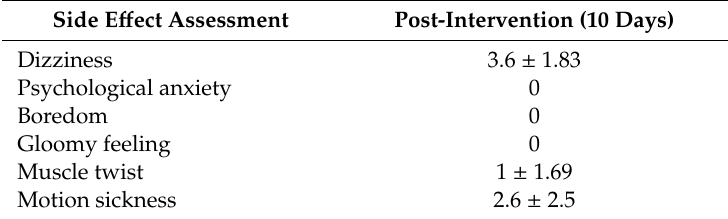
Table 4. Adverse e ff ects evaluation after the